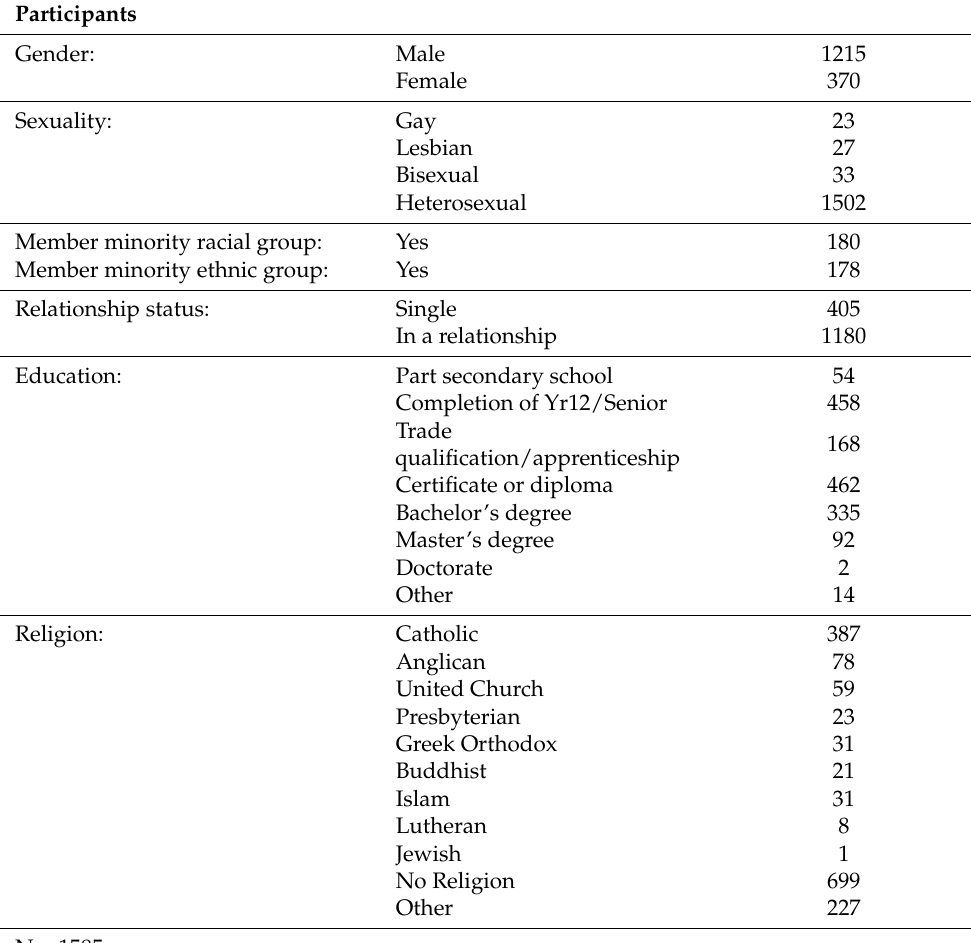
Table 1. Participants’ Demographic